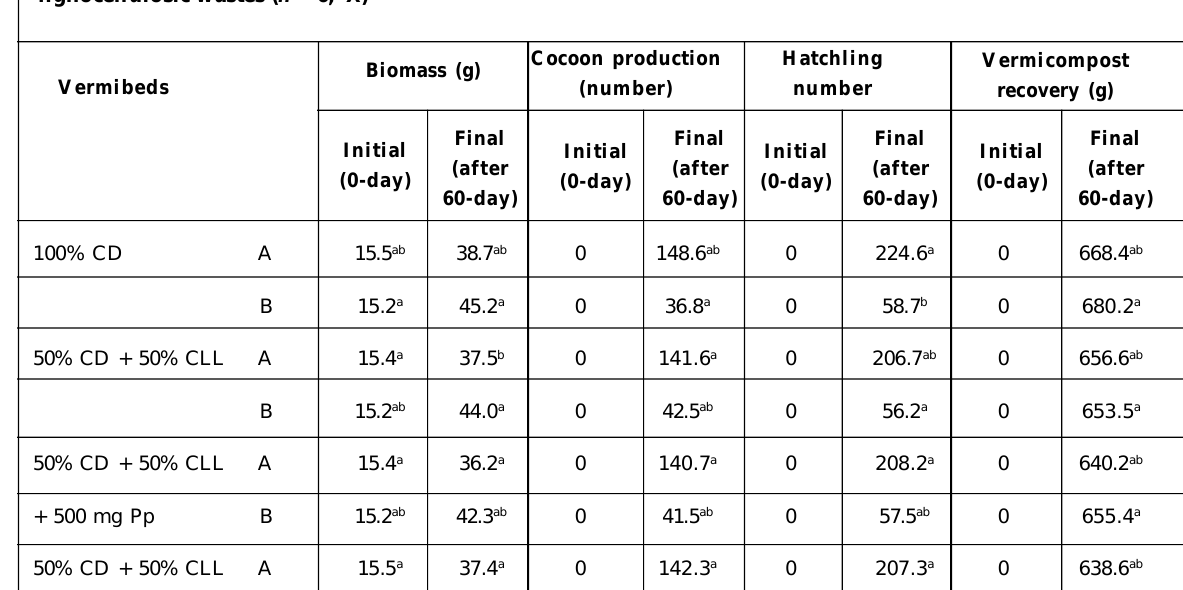
Table 5: Activity of earthworms ( P. excavatus and L. mauritii ) during integrated system of vermicomposting — lignocellulosic wastes ( n = 6; X